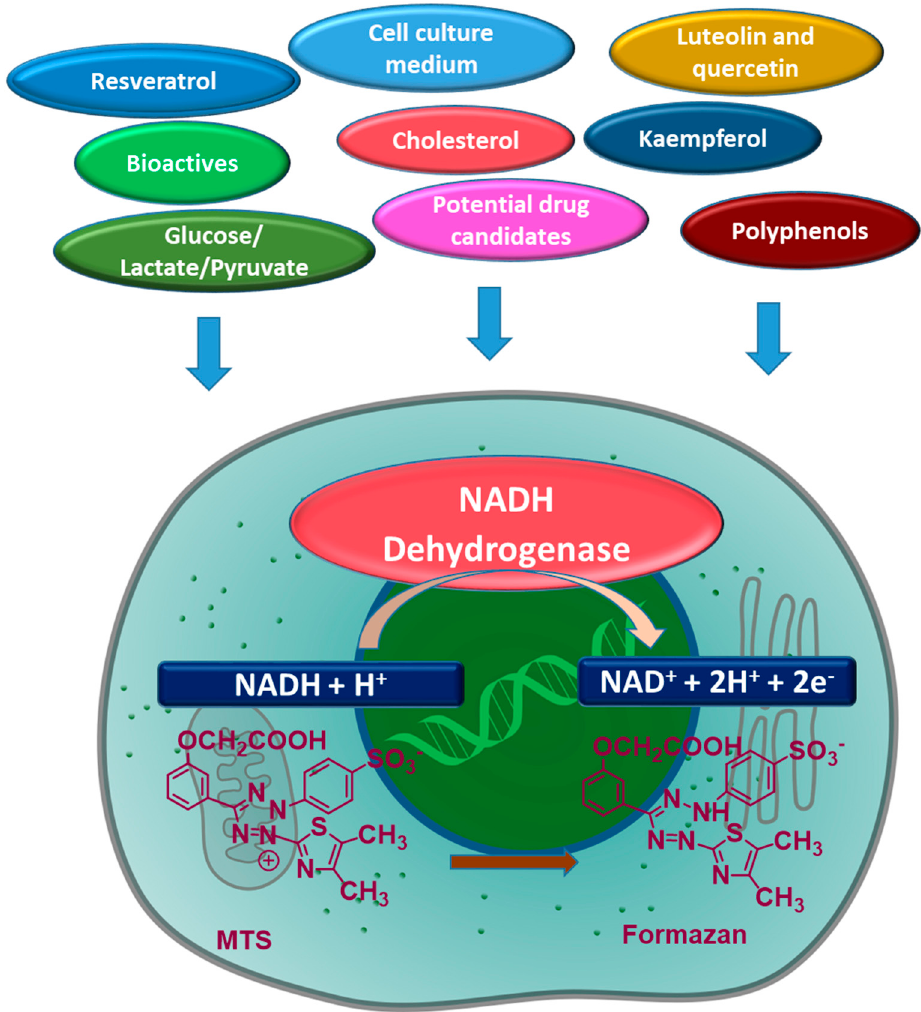
Figure 4. Factors affecting the reduction/conversion of MTS (3-(4, 5-dimethylthiazol-2-yl)-5-(3- carboxymethoxyphenyl)-2-(4-sulfonyl)-2H-tetrazolium) to formazan by metabolically active cells.